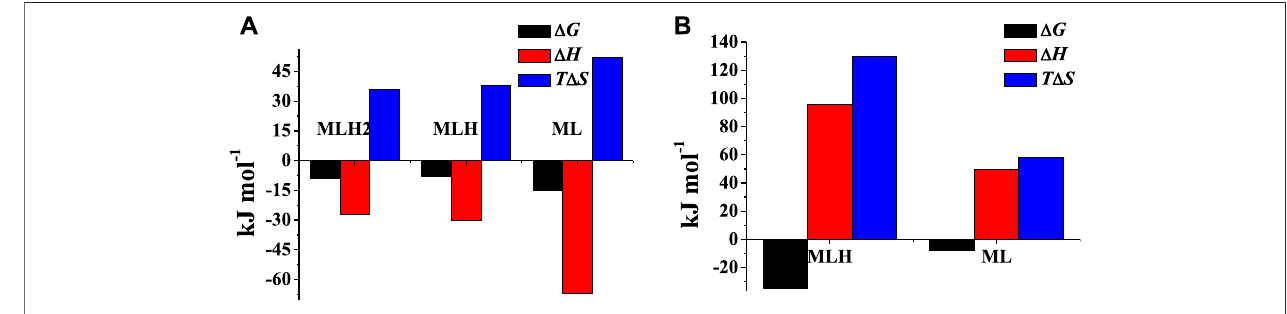
FIGURE 6 | Formation thermodynamic parameters of (A) Mg 2+ - PEA and (B) Mg 2+ - PPC species at t = 25 ° C and I = 0.15 mol L − 1 in NaCl.